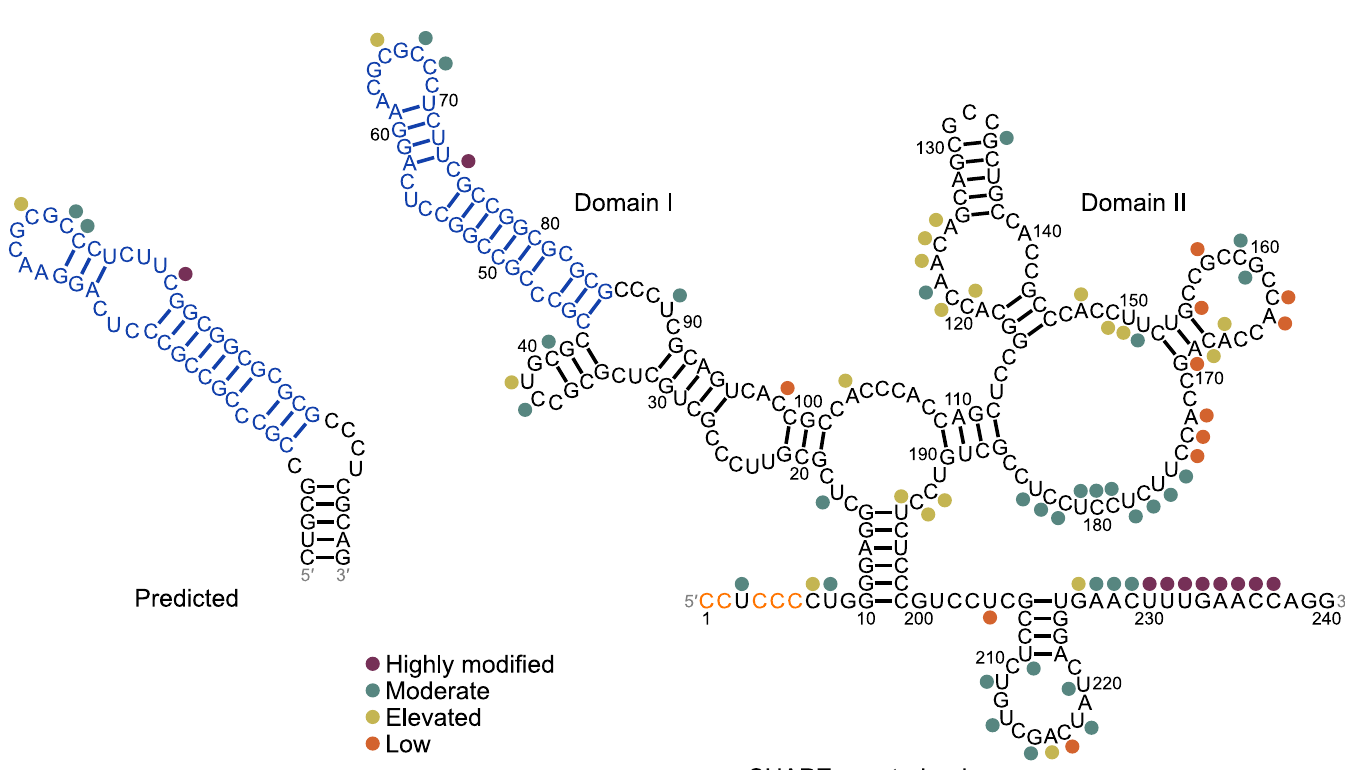
Fig 5. Predicted and SHAPE constrained structures of the human 5 0 UTR. Predicted structure corresponds to nt 120–176. Structure determined by SHAPE analysis corresponds to the 240 nt tau IRES.[73] The conserved 5 0 -CCUCCCC-3 0 sequence that promotes cap-dependent translation is colored orange. Blue nucleotides in the SHAPE constrained structure correspond to those in the predicted structure. Nucleotides in the SHAPE constrained structure that were modified in SHAPE analysis are indicated by circles colored according to SHAPE reactivity (see figure key). For reference, nucleotides in the predicted structure that correspond to those in the SHAPE- constrained structure are labeled with the respective colored circles. SHAPE reactivities were obtained from ref.